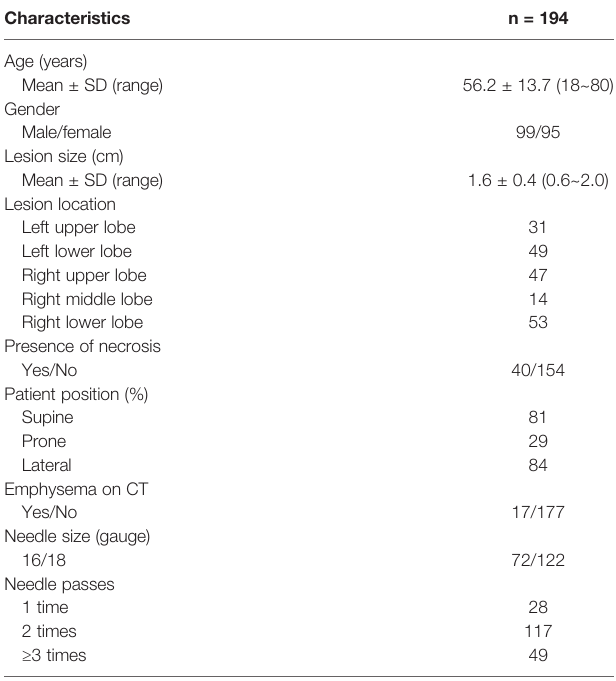
TABLE 1 | Patients characteristics and lesion pro fi les (n = 194). Characteristics